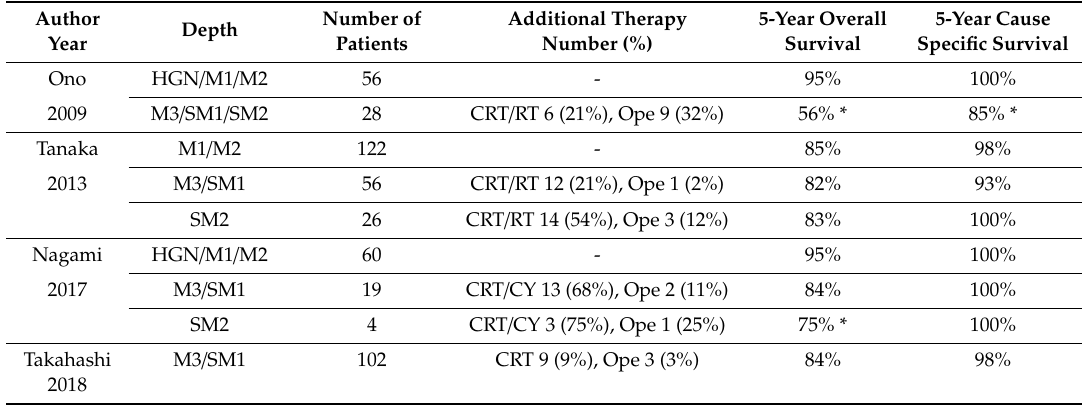
Table 1. The depth of superficial esophageal squamous cell carcinoma and the long-term outcomes of endoscopic submucosal